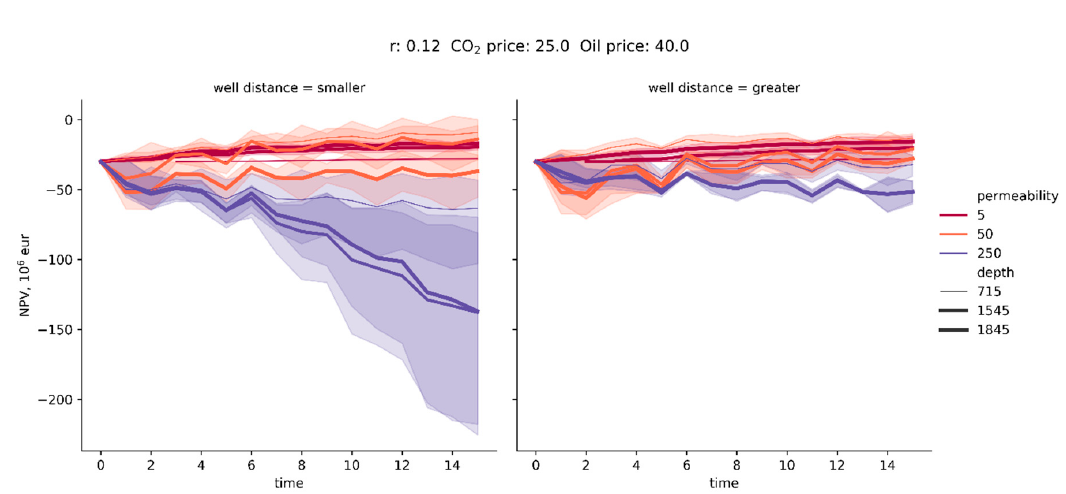
Figure A1. Time versus NPV for the realistic scenario with 40 €/MWh electricity price.